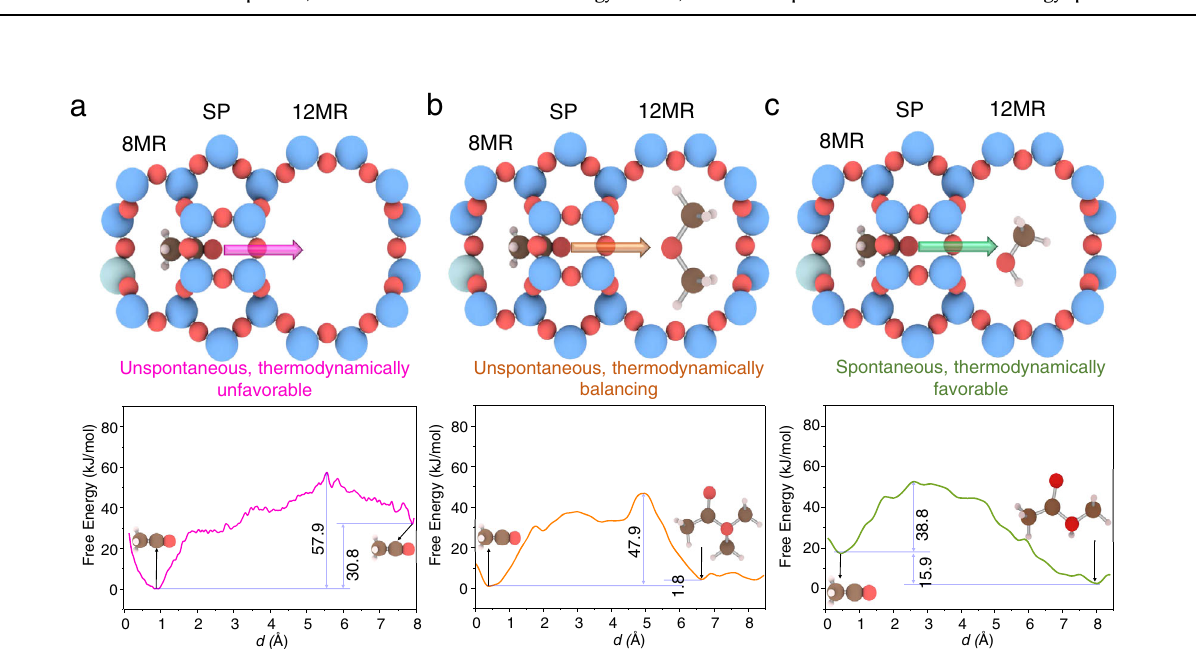
Fig. 4 | The migration of the acylium ion from the side pocket to the 12MR channel. a Free energy pro fi le of the movement of the acylium ion from the side pocket to the 12MR channel without MeOH or DME in the 12MR channel, b free energy pro fi le of the movement of the acylium ion into the 12MR channel